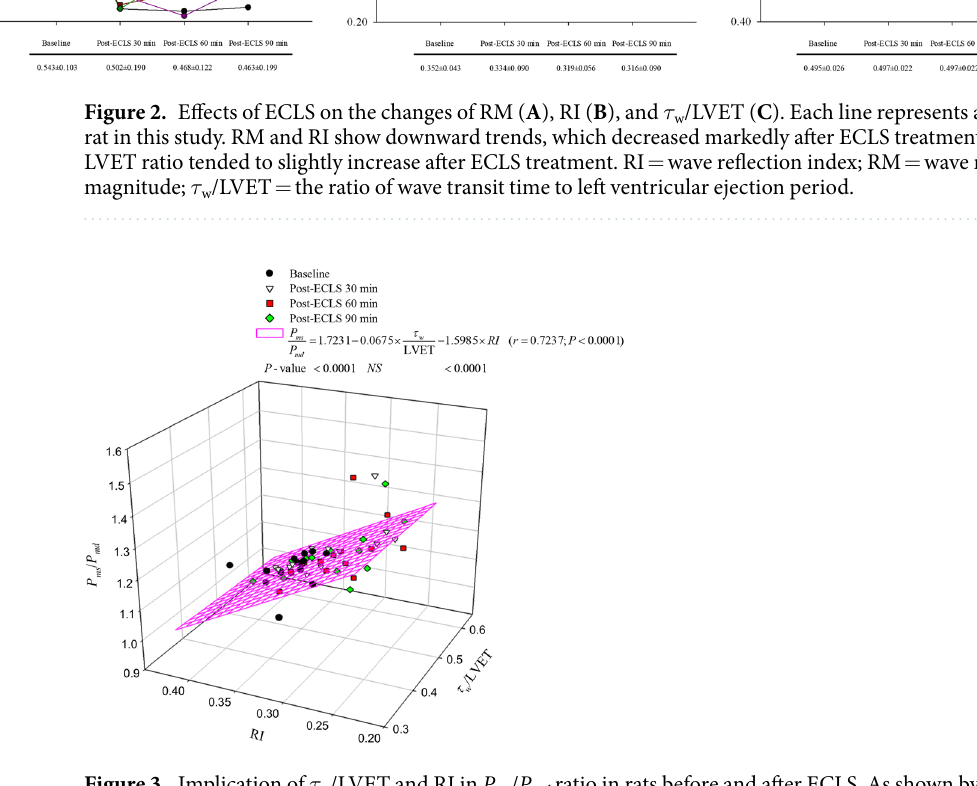
Figure 3. Implication of τ w /LVET and RI in P ms / P md ratio in rats before and after ECLS. As shown by multiple linear regression analysis, only the correlation between P ms / P md and RI reached significance, suggesting that the P ms / P md impaired by ECLS could be affected by the magnitude of RI rather than the wave transmission time ( τ w / LVET). P md = mean diastolic pressure; P ms = mean systolic pressure; RI = wave reflection index; τ w /LVET = the ratio of wave transit time to left ventricular ejection